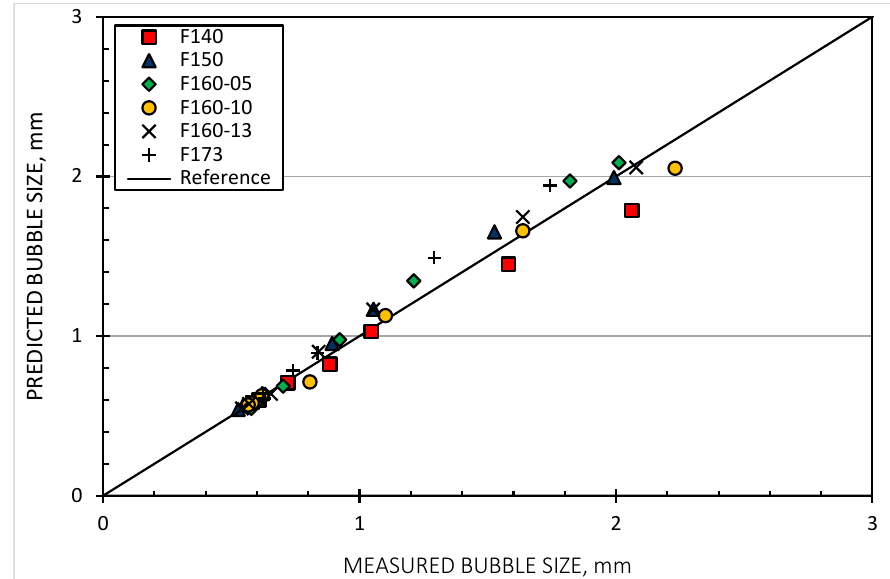
Figure 9. Predicted vs. measured bubble size (Molerus model).